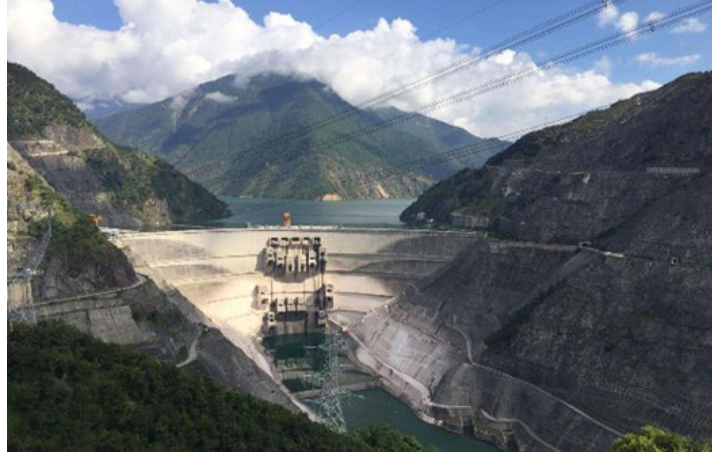
Figure 5. Airscape of Xiaowan Arch Dam.